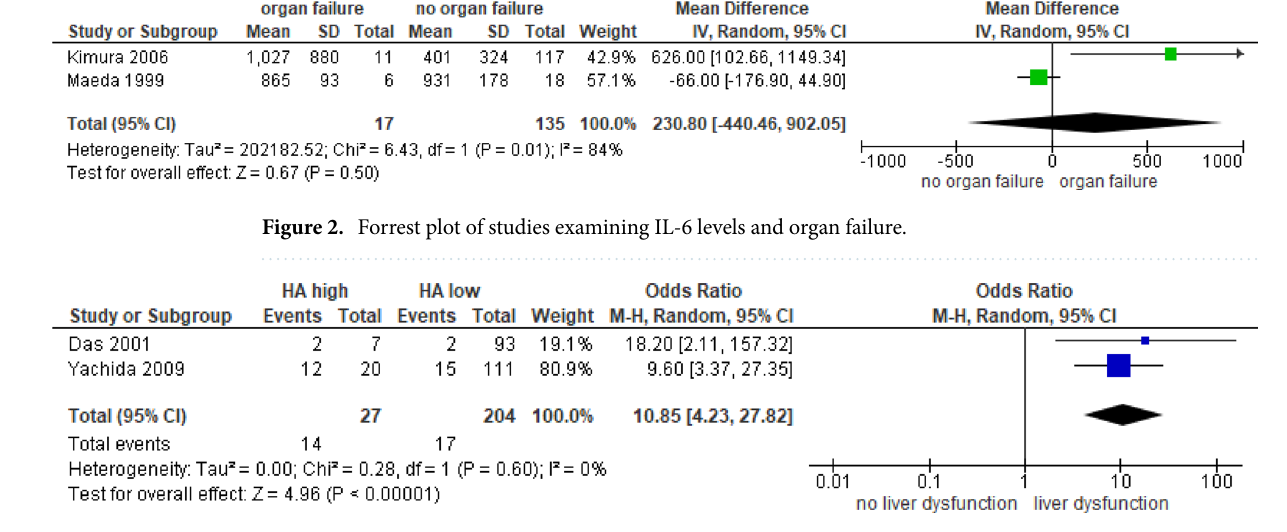
Figure 3. Forrest plot of studies examining preoperative serum HA levels and liver